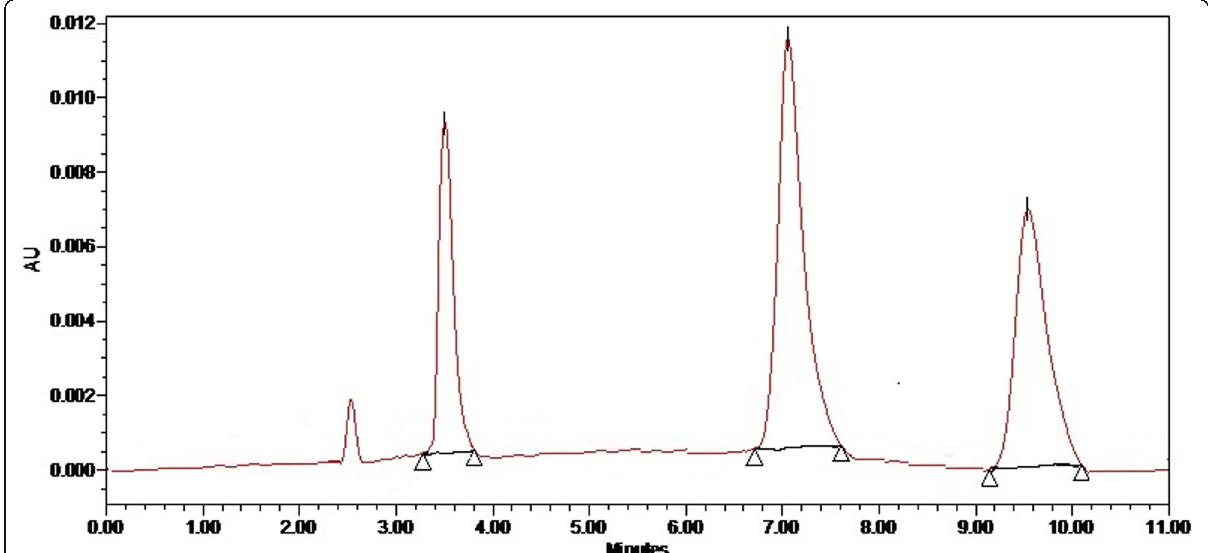
Fig. 3 Chromatogram for Perindopril erbumine (4 μ g/mL), Indapamide (1.25 μ g/mL), and Amlodipine besylate (5 μ g/mL) using mixture of acetonitrile: methanol: water (30:20:50, v/v/v) was further adjusted to pH 3.0 with 1.0% O – phosphoric acid as a mobile